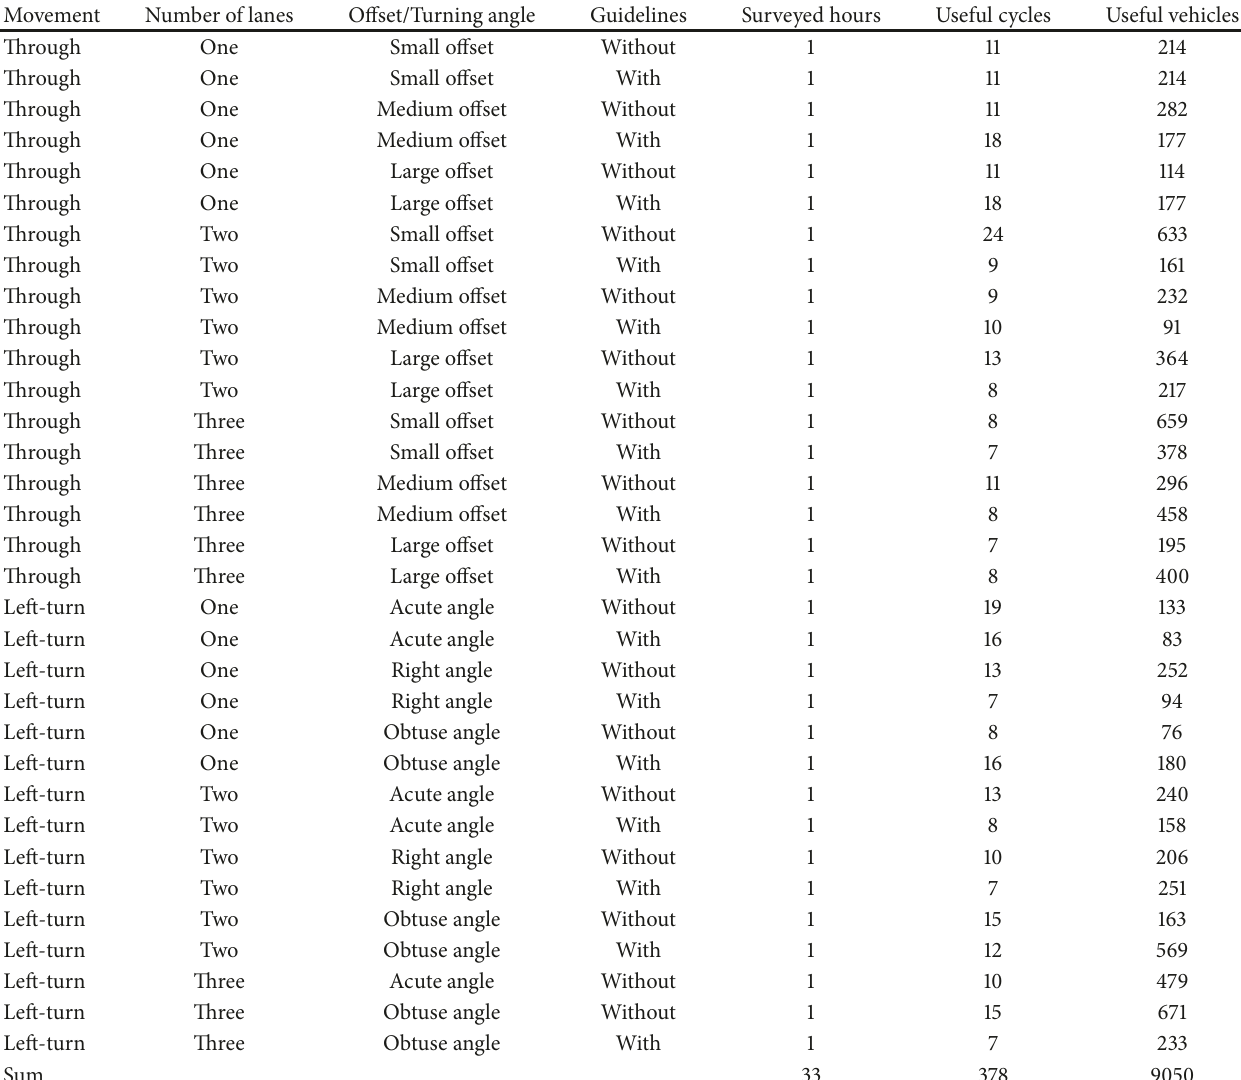
Table 2: Surveyed